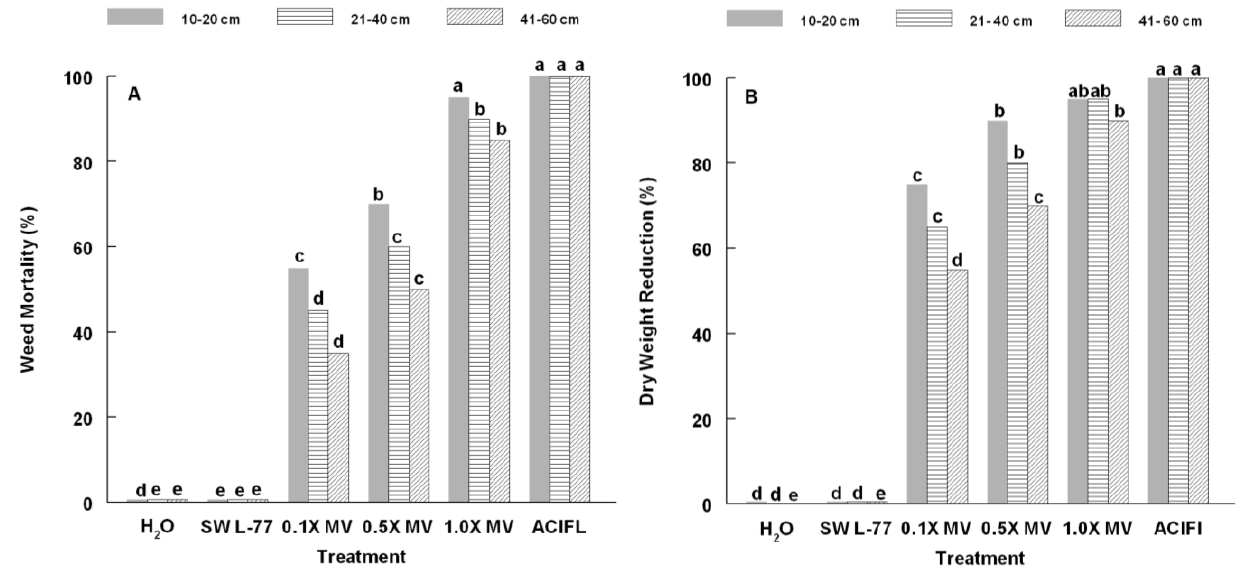
Figure 3. Biological control of hemp sesbania at various growth stages in rice field plots using several Myrothecium verrucaria mycelial inoculum concentrations at Stoneville, MS. Acifluorfen was applied post-emergence at 0.56 kg ai ha −1 . A = hemp sesbania mortality, and B = hemp sesbania dry weight reduction. Histogram bar values for each parameter with the same letter are not significantly different at p = 0.05 using Fisher’s least significant